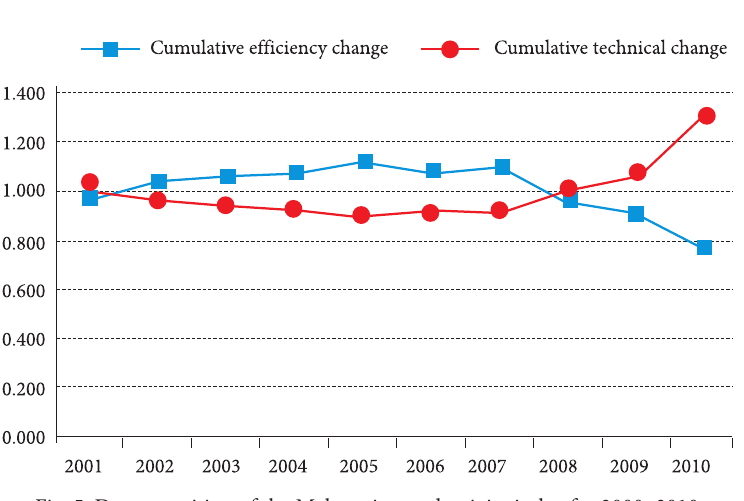
Fig. 5. Decomposition of the Malmquist productivity index for